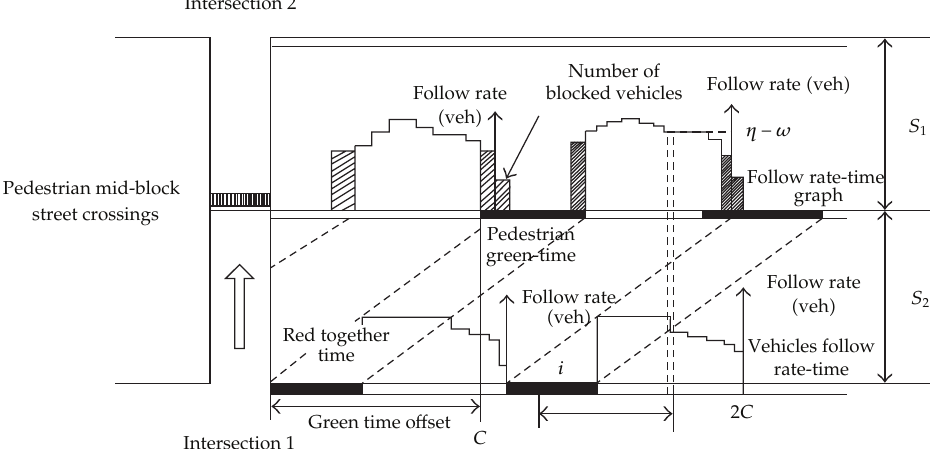
Figure 1: Distance-time-flow rate graph between two